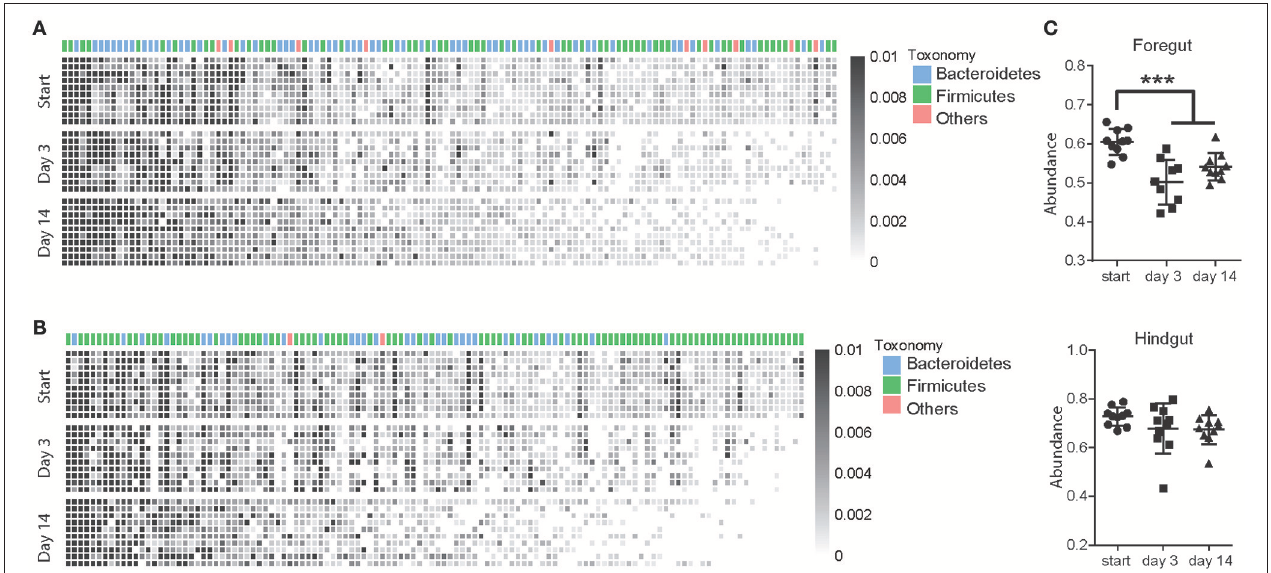
FIGURE 4 | Antibiotics altered high-confidence OTUs in foregut and hindgut. (A,B) High-confidence OTUs change in foregut (A) and hindgut (B) after antibiotics usage. Each column represented one OTU and each row represented one individual cow from pre-treated period (Start) to 3 and 14 days after antibiotics exposure, taxonomic assignment is indicated at the top of each column. (C) Total abundance of high-confidence OTUs change in foregut and hindgut after antibiotics exposure. Data are expressed as mean ± s.d. *** P <